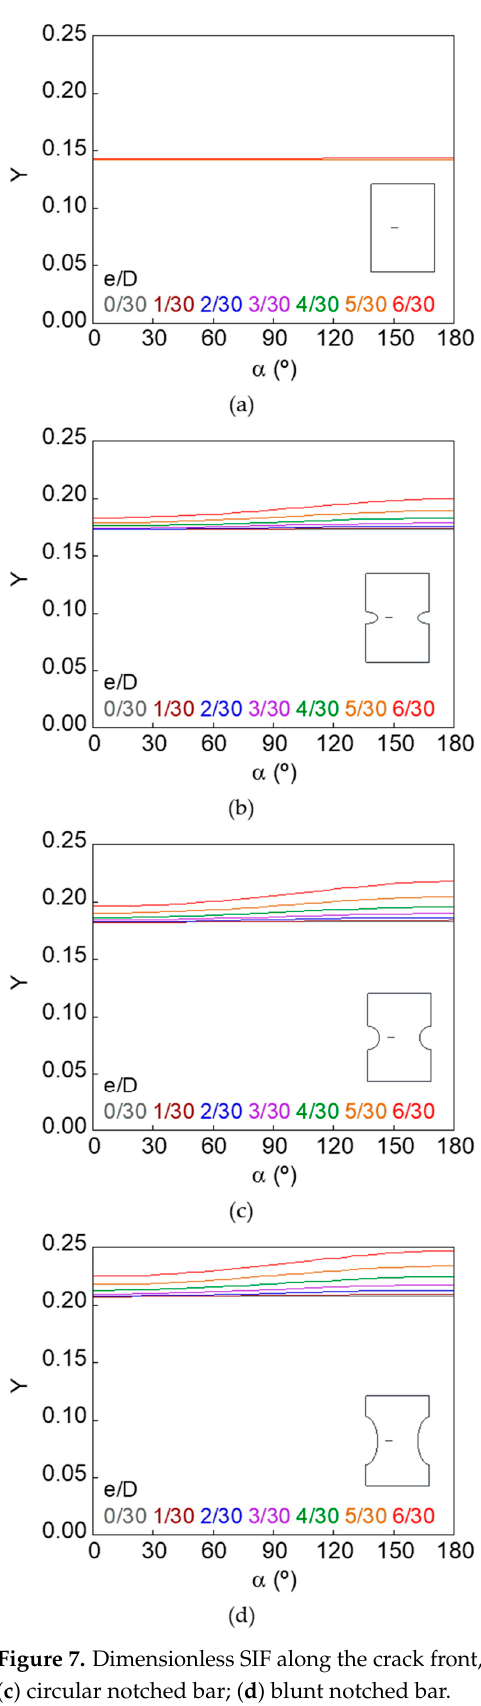
Figure 7. Dimensionless SIF along the crack front, d / D = 3/30: ( a ) smooth bar; ( b ) sharp notched bar; ( c ) circular notched bar; ( d ) blunt notched bar.